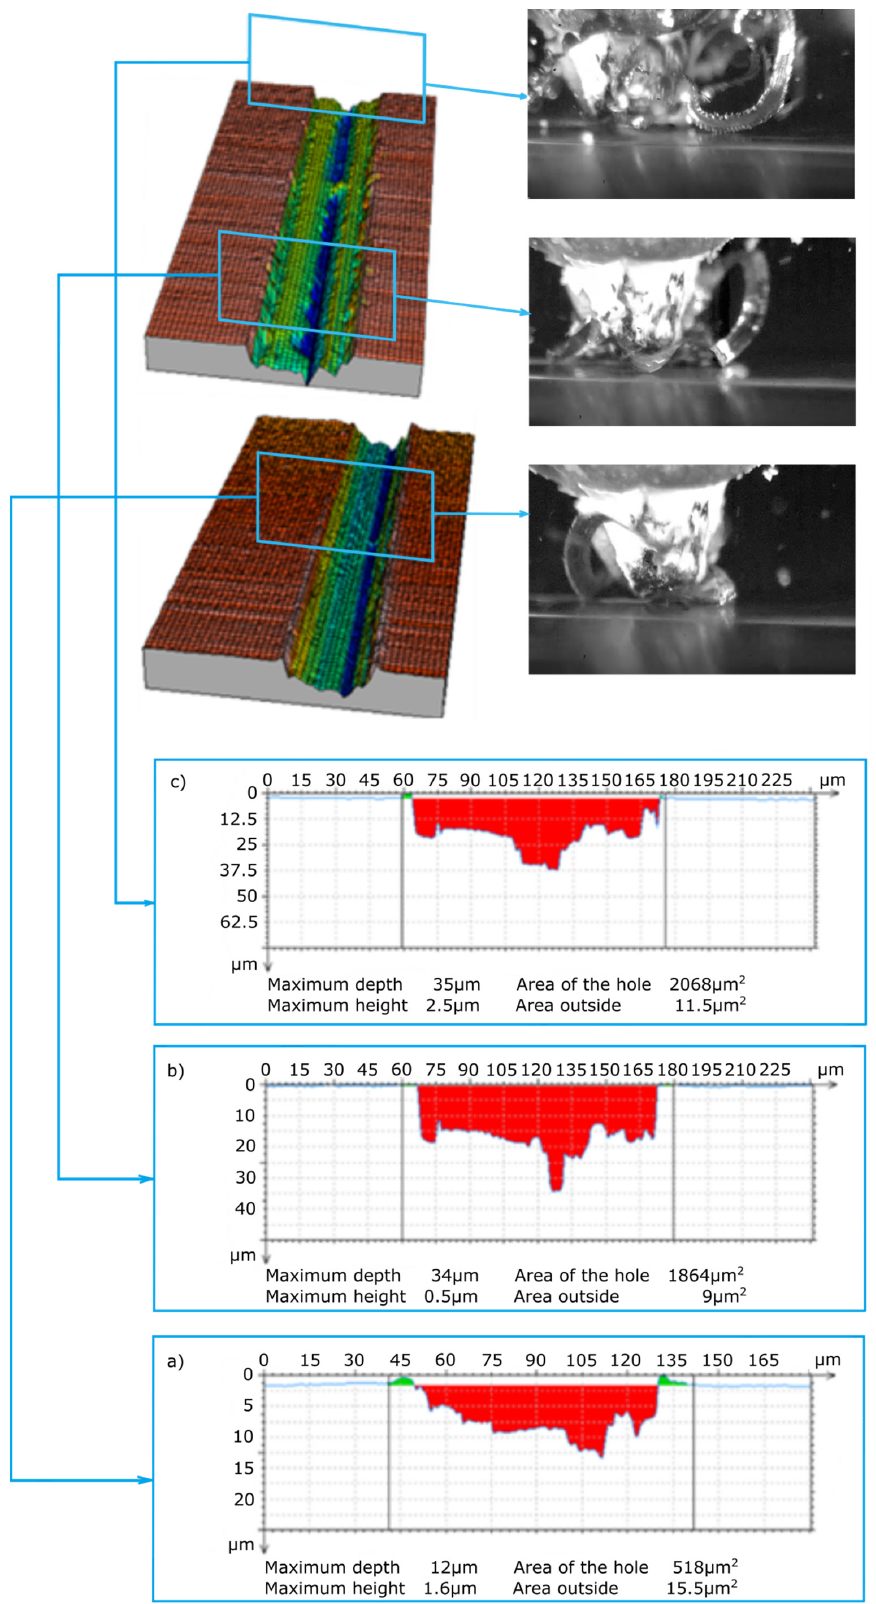
Figure 8. View of the scratch formed by the ZS2 abrasive grain and cross-sections of the scratch for depths of cut: ( a ) 10 µm, ( b ) 15 µm and ( c ) 20 µm.